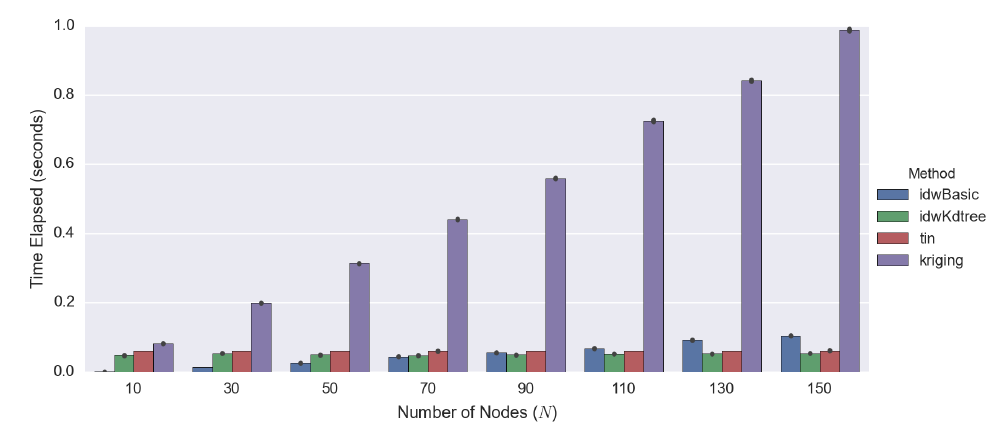
Figure 8. This graph demonstrates a comparison of computational efficiency for different 2D spatial interpolation techniques, with the data based on Table 3.